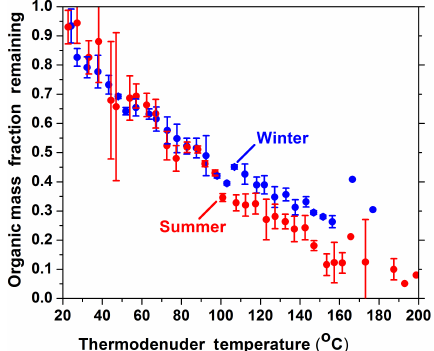
Figure 3. Loss-corrected average OA thermograms for summer (red circles) and winter (blue squares) campaigns. The error bars corre- spond to ± 2 standard deviations of the mean. Points with no error bars correspond to a single